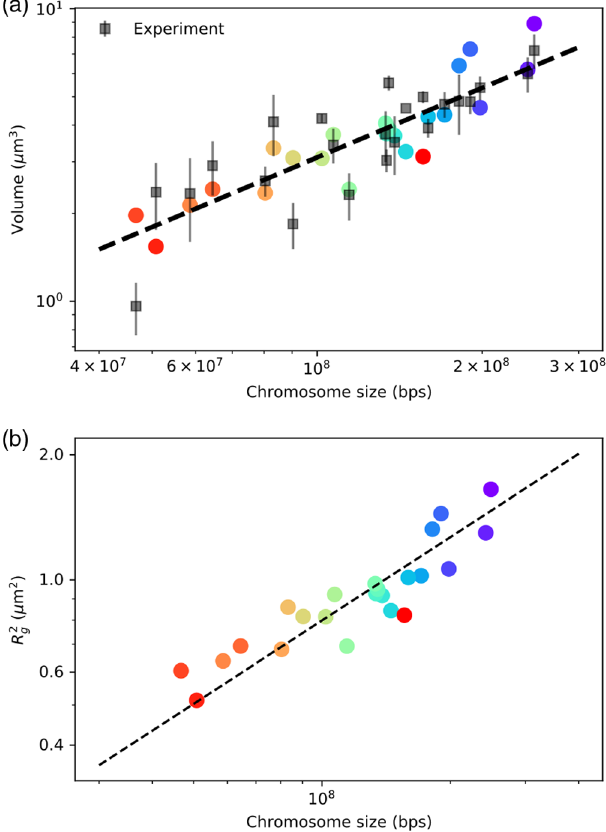
FIG. 3. (a) Plot of the square of the radius of gyration R 2 function of the chromosome size. The dashed line is a fit to the data with the slope 0.54, which implies that R are for the 23 chromosomes. (b) Volume of each chromosome versus the length in units of base pairs. The experimental values (black squares) are computed using the data in Ref. [30]. The dashed line is the fit to the experimental data with slope of 0.8. Volume of each chromosome is calculated using λ V the percentage of volume of the nucleus, V provided in Fig. S5 in Ref. [30], and V 3 . 5 μ m is the radius of human lymphocyte cell nucleus r nuc ¼ [30]. Volumes of the chromosomes obtained using theory and computation are calculated using ð 4 = 3 Þ π R 3 Pearson correlation coefficient between predicted values, without any adjustable parameters, and the experimental data is